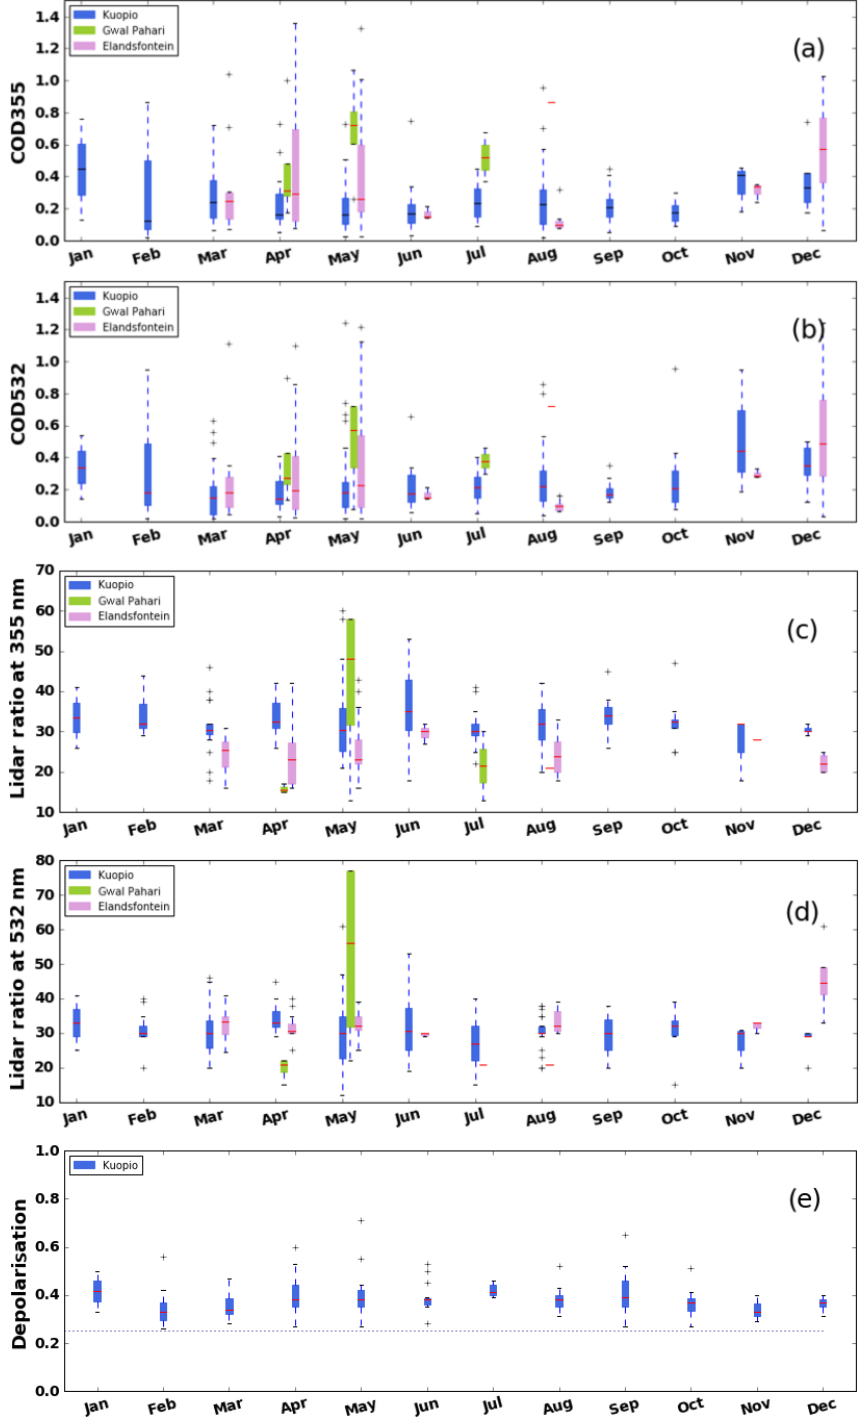
Figure 5. Mean optical depth (multiple-scattering-corrected) values at 355nm (a) , mean optical depth (multiple-scattering-corrected) values at 532nm (b) , lidar ratio at 355nm (c) , lidar ratio at 532nm (d) and particle depolarisation ratio (e) for the detected cirrus layers for the study period for the three regions. Horizontal line in box: median. Boxes: the upper and lower quartile. Whisker: extreme values. Red line stands for the mean values for every